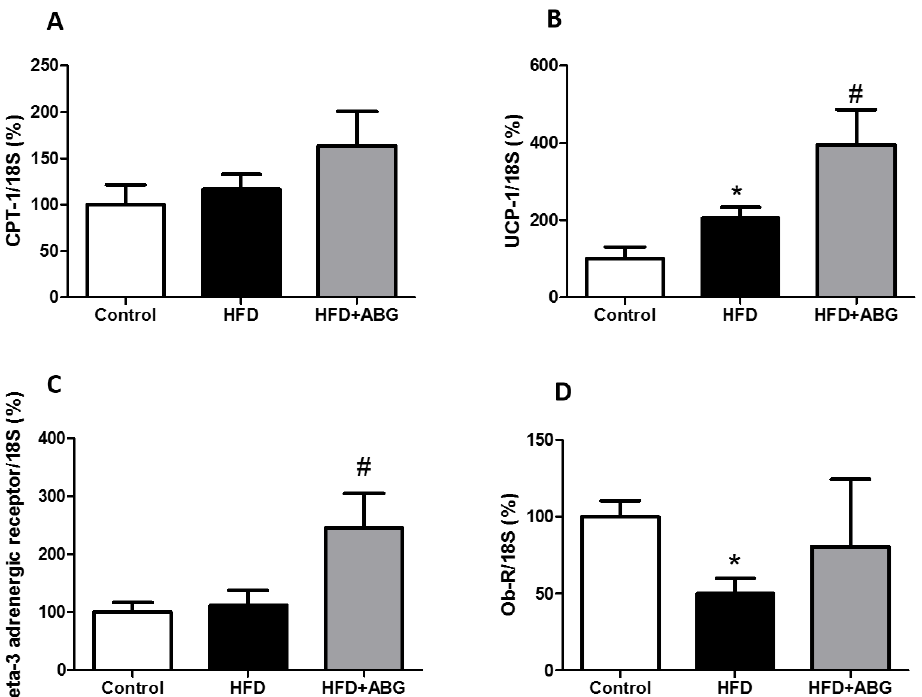
Figure 7. mRNA amounts of carnitine palmitoyltransferase I ( A ), uncoupling protein 1 ( B ), beta-3 adrenergic receptor ( C ) and leptin receptor ( D ) in brown adipose tissue of rats fed a standard chow (control) or a high-fat diet (HFD)/sucrose diet and treated with vehicles or HFD + ABG. Data are represented as mean ± SEM; n = 8 samples/group. * p < 0.05 vs. control; # p < 0.05 vs. HFD.